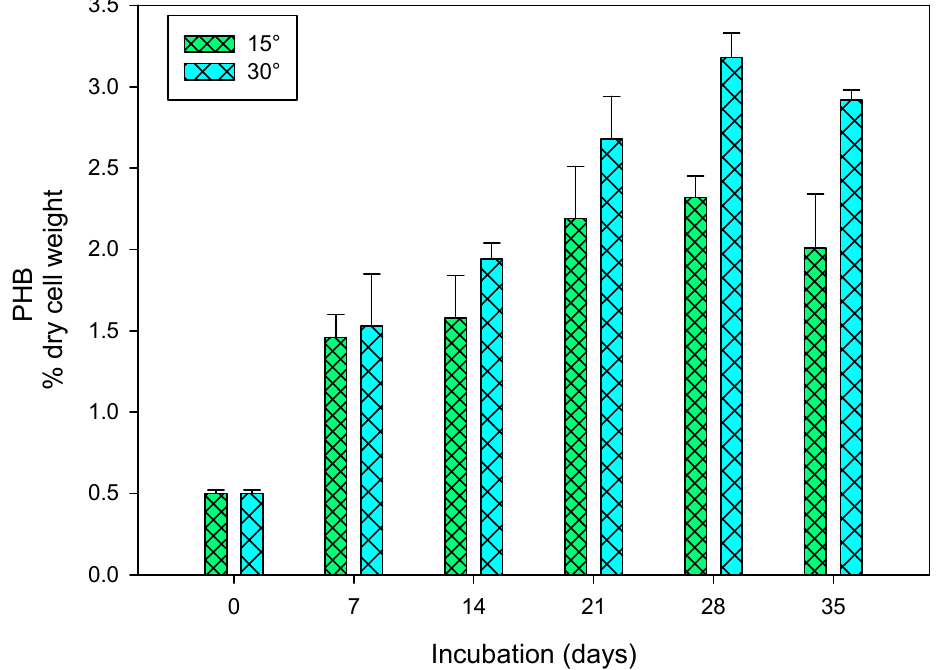
Figure 6. Production of PHB in S. geitleri in response to temperature. Values are the mean ( n = 3) ± SD.